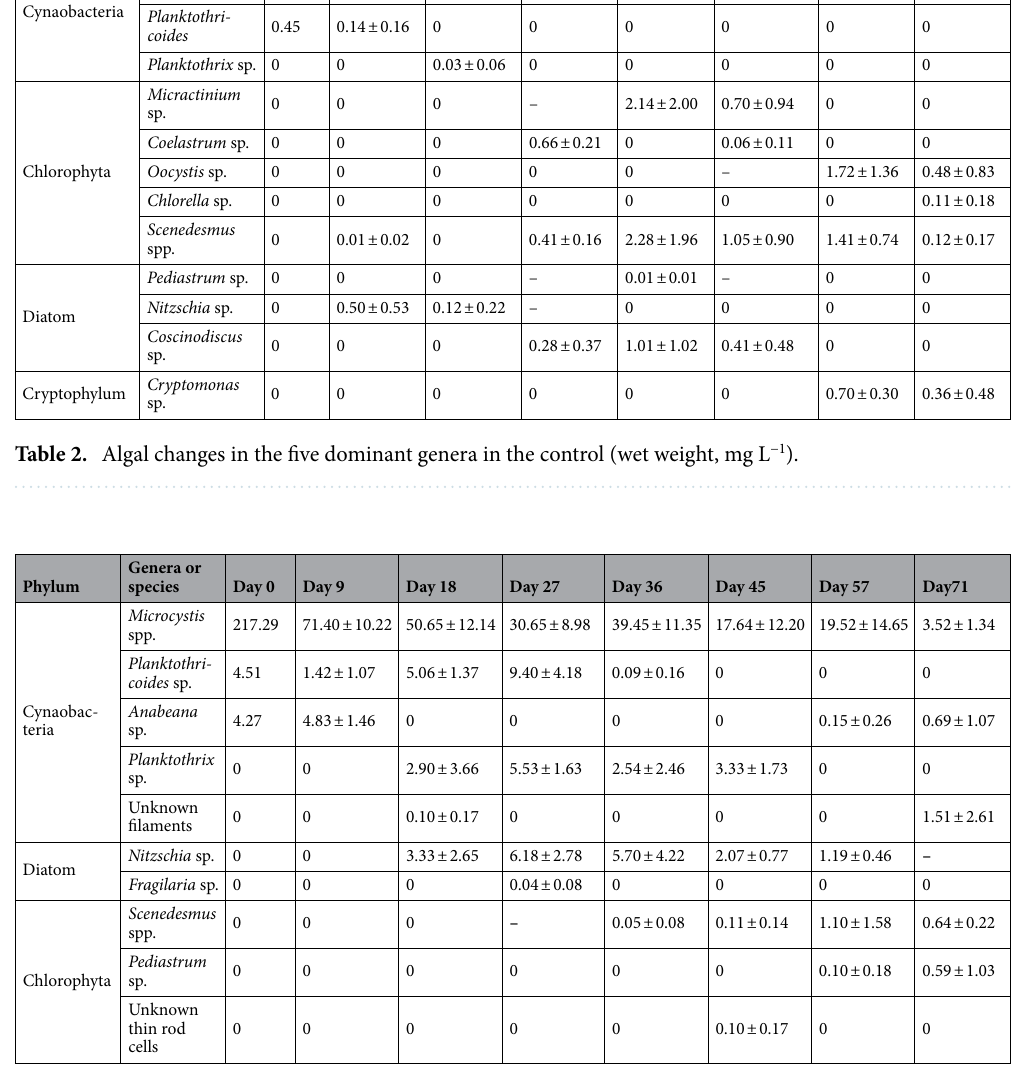
Table 3. Algal changes in the five dominant genera in treatment Low (wet weight, mg L −1